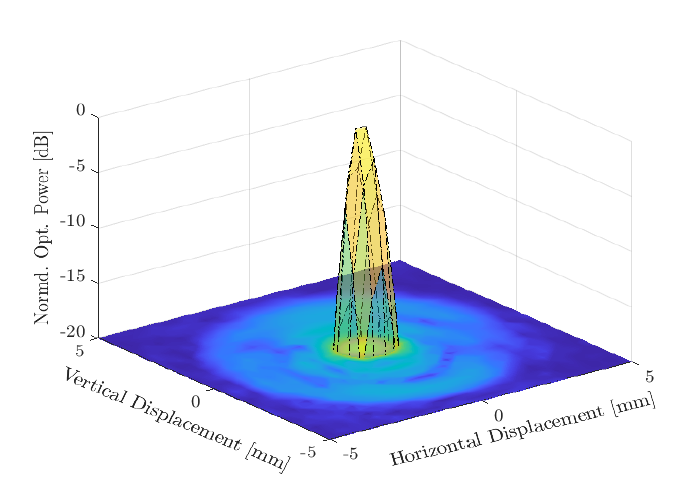
Figure 9. Working region for the 2nd-stage optical-power-based alignment, P th = − 20dB.